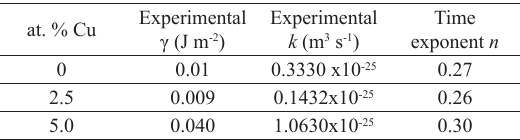
Table 2. Experimental values of γ, and κ and n constants for present work alloys. at. %